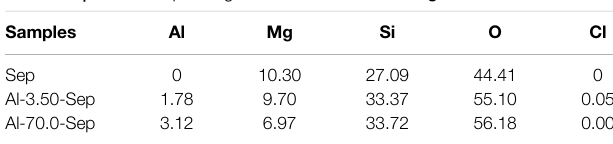
TABLE 4 | The corresponding EDS results marked in Figures 3D – F .